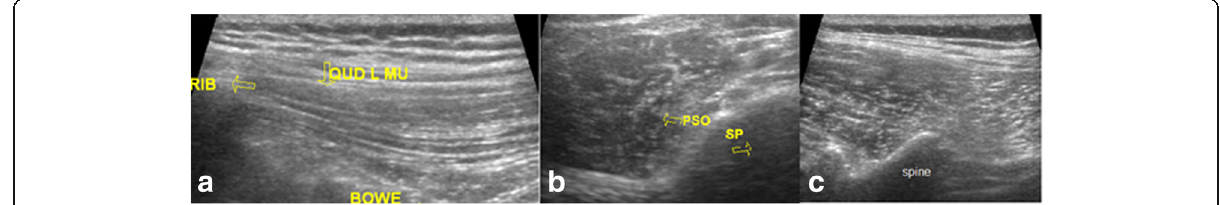
Fig. 3 The ultrasound images (a) for quadratus lumborum muscle and for the psoas muscle as it arises from the spine in a transverse section (b) and in a longitudinal section in